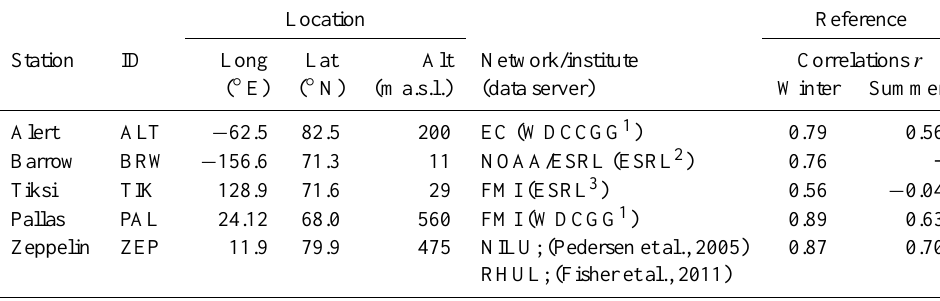
Table 1. Observation site characteristics. The site location is displayed in Fig. 1.